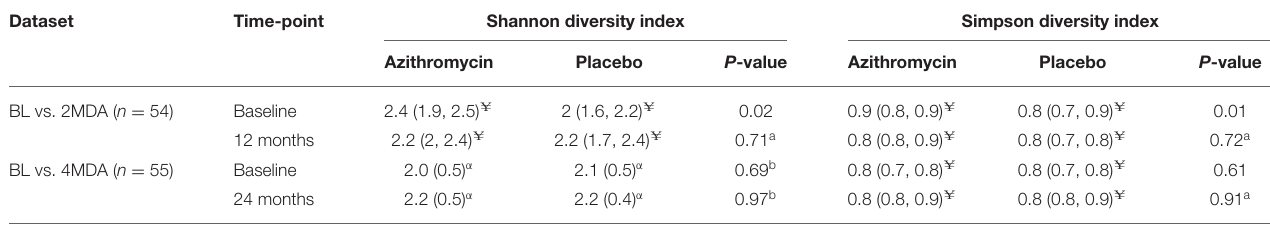
U Median (25 th , 75 th quartile). α Mean (SD).